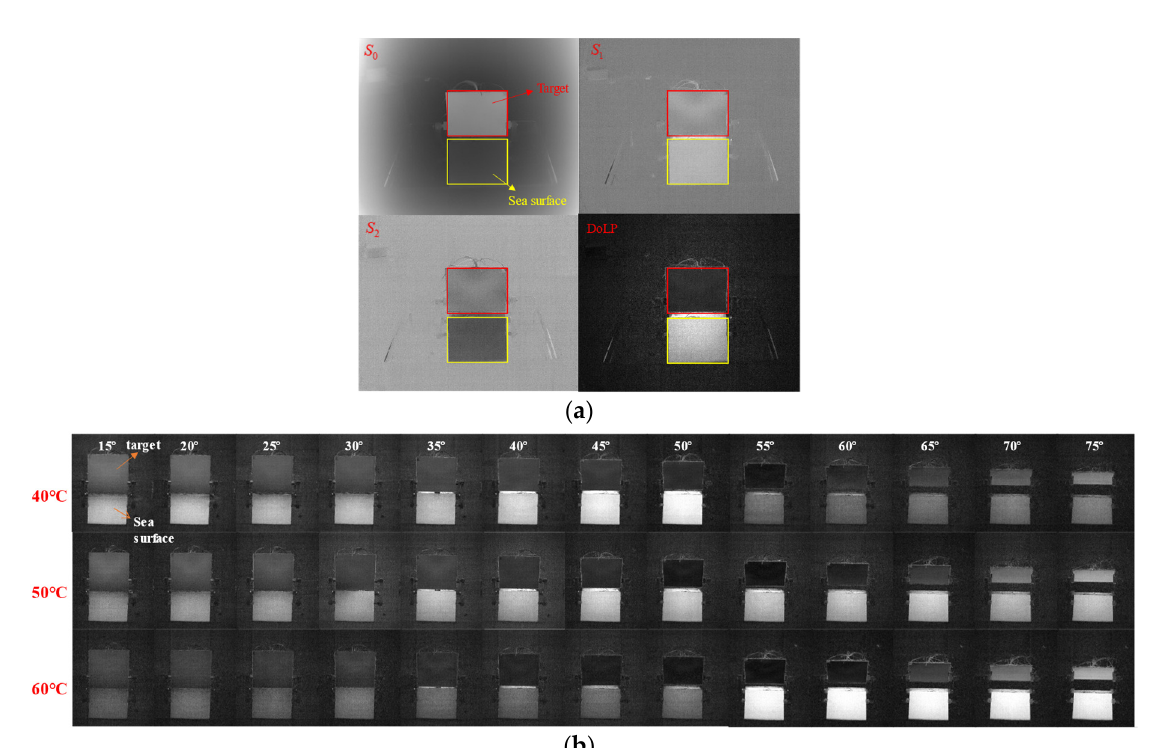
S , S and S with object temperature being 50 °C and observa- 0 1 2